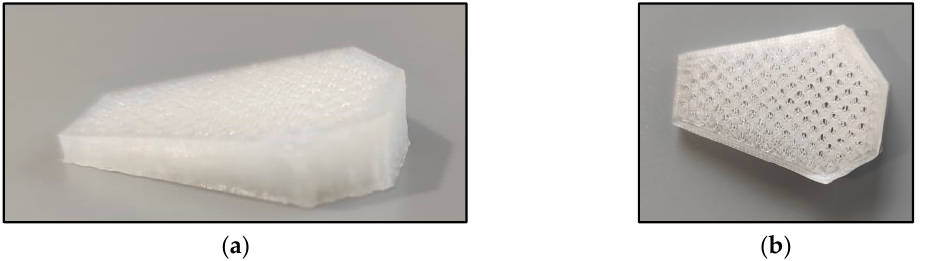
Figure 1. PLA implant. ( a ) Lateral view of the PLA implant. ( b ) Frontal view of the PLA implant. Platelet-rich plasma (PRP) is a concentration of autologous platelets in a small volume of plasma produced by centrifuging the patient’s blood [16]. Platelets play an